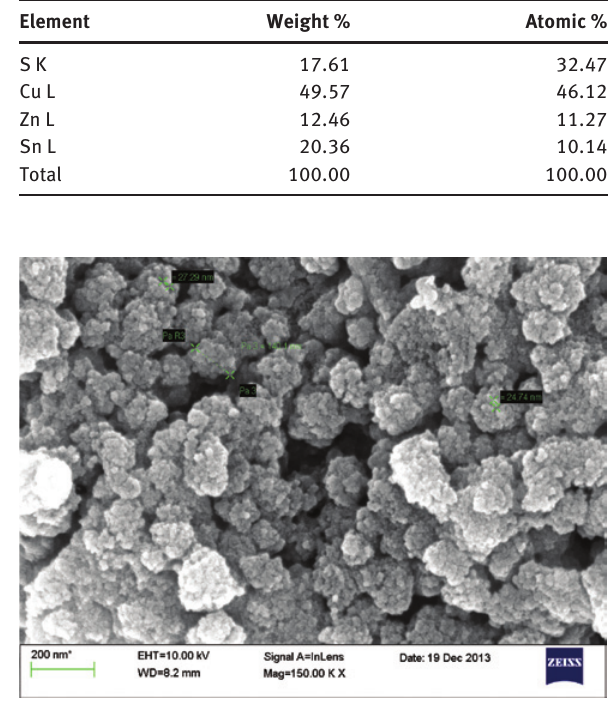
Figure 5. The particle size analysis from the SEM micro-